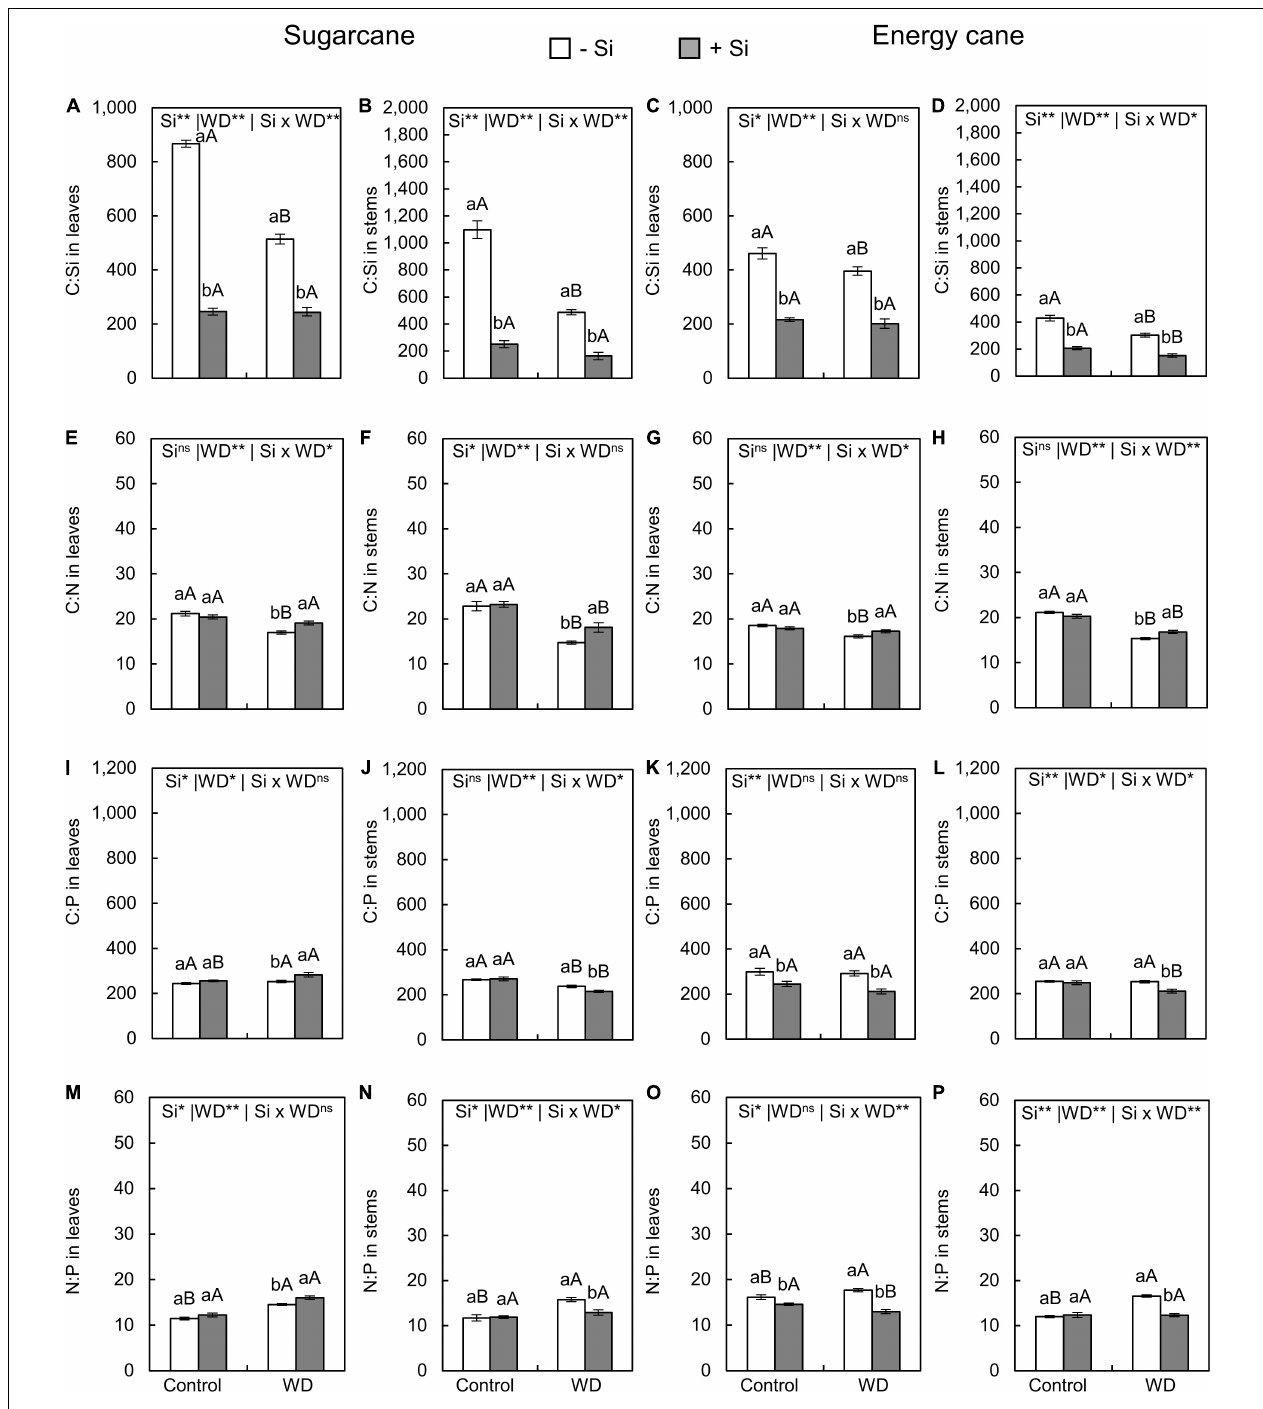
FIGURE 5 | C:Si, C:N, C:P, N:P ratios in the leaves and stems of sugarcane (A,B,E,F,I,J,M,N) and energy cane (C,D,G,H,K,L,O,P) in -Si and + Si under adequate water regime (control) and in WD for a period of 7 to 60 days after transplantation. ** and * significant with 1 and 5% probability, respectively, and ns, not significant by the F -test. Lowercase letters indicate differences in relation to Si and capital letters in relation to water deficit. n = 6. Si × WD: interaction.